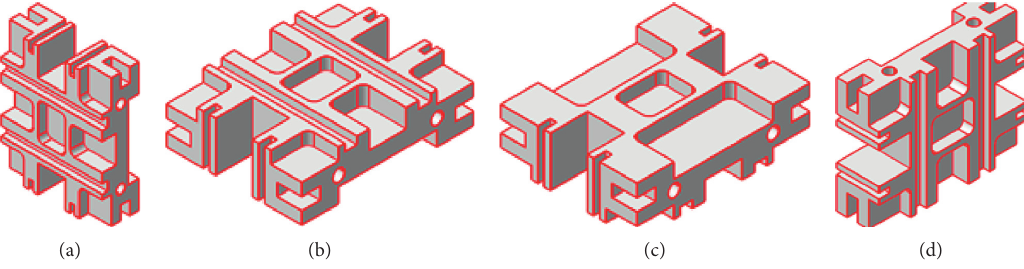
Figure 13: (a) Orientation no. 1; (b) orientation no. 2; (c) orientation no. 3; (d) orientation no.